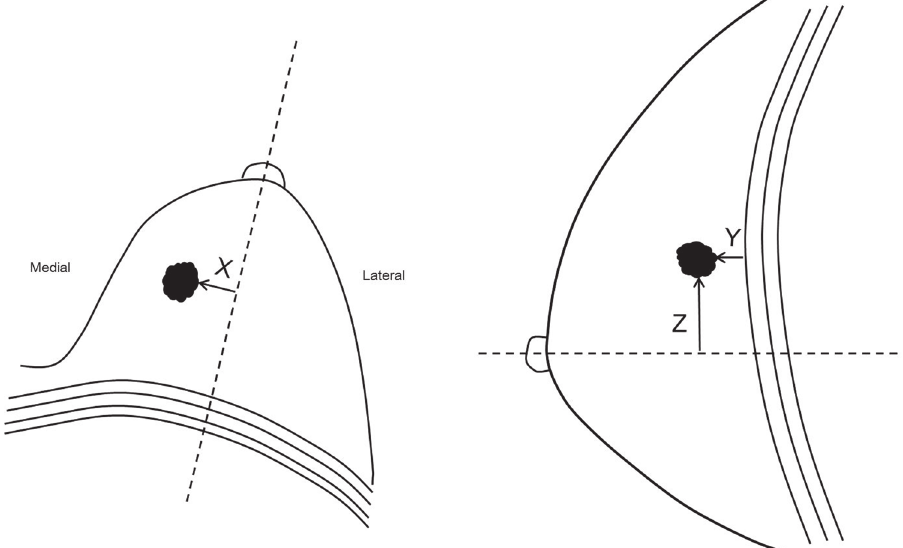
Figure 1. Diagram of tumor distances in the three-dimensional planes using breast MR images. Diagram shows how the distances in the x, y, and z planes were measured in axial and sagittal breast MR images. We measured the shortest distances for x-axis (X) and z-axis (Z) measurements of breast cancer in relation to the imaginary lines from the nipple and for y-axis (Y) measurement from the chest